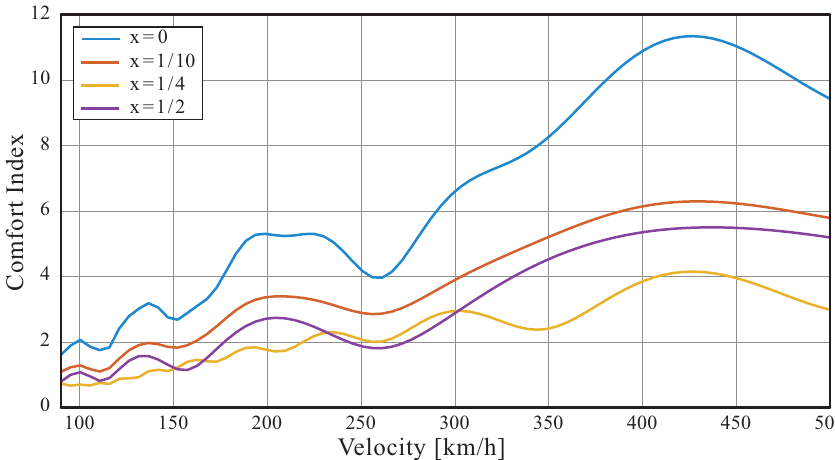
Figure 15. Comfort index at four locations on the beam versus v with outstretched upper